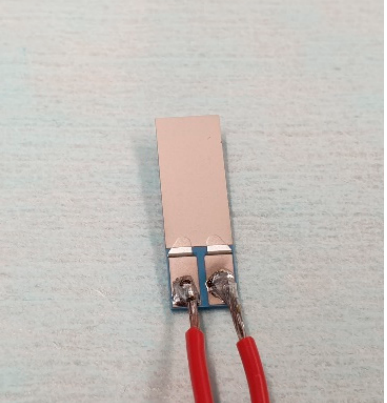
Figure 2. Deposition of dielectric layer on LTCC.